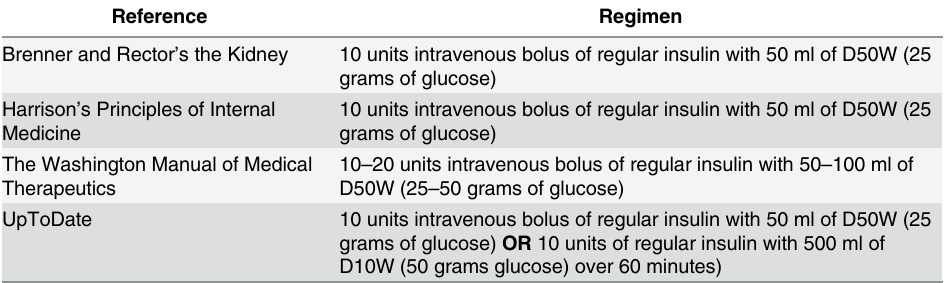
Table 1. Recommended regimens for administration of insulin in the treatment of acute